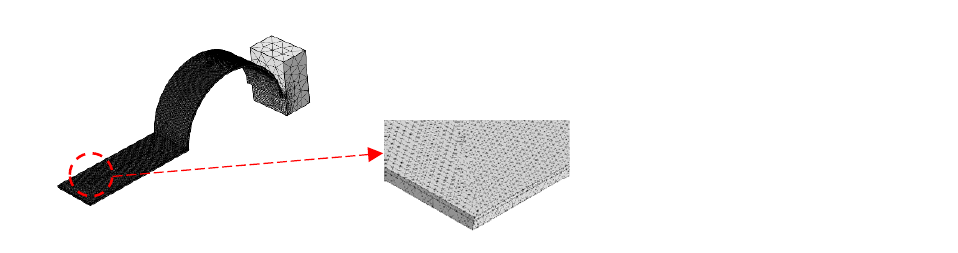
Figure 3. Schematic diagram of mesh division.